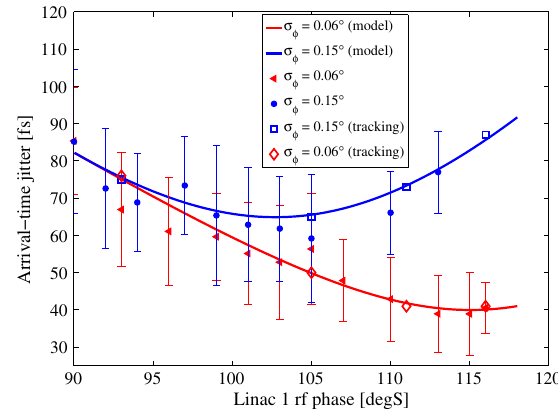
FIG. 9. Measurements, theoretical and numerical expectation of the ATJ versus linac phase for a rf phase jitter of 0.06 (cid:4) and 0.15 (cid:4) . R 56 ¼ (cid:3) 41 mm , (cid:1) t i from the injector is 80 fs